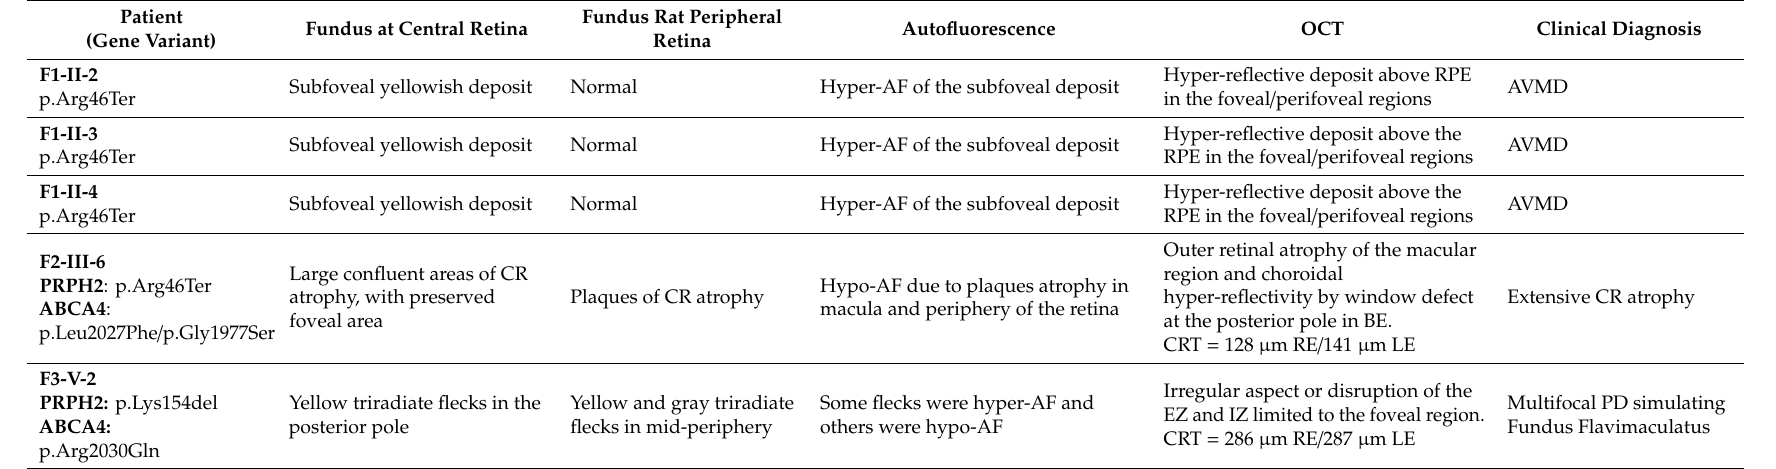
Table 2. Image pictures, description of structural changes, and clinical